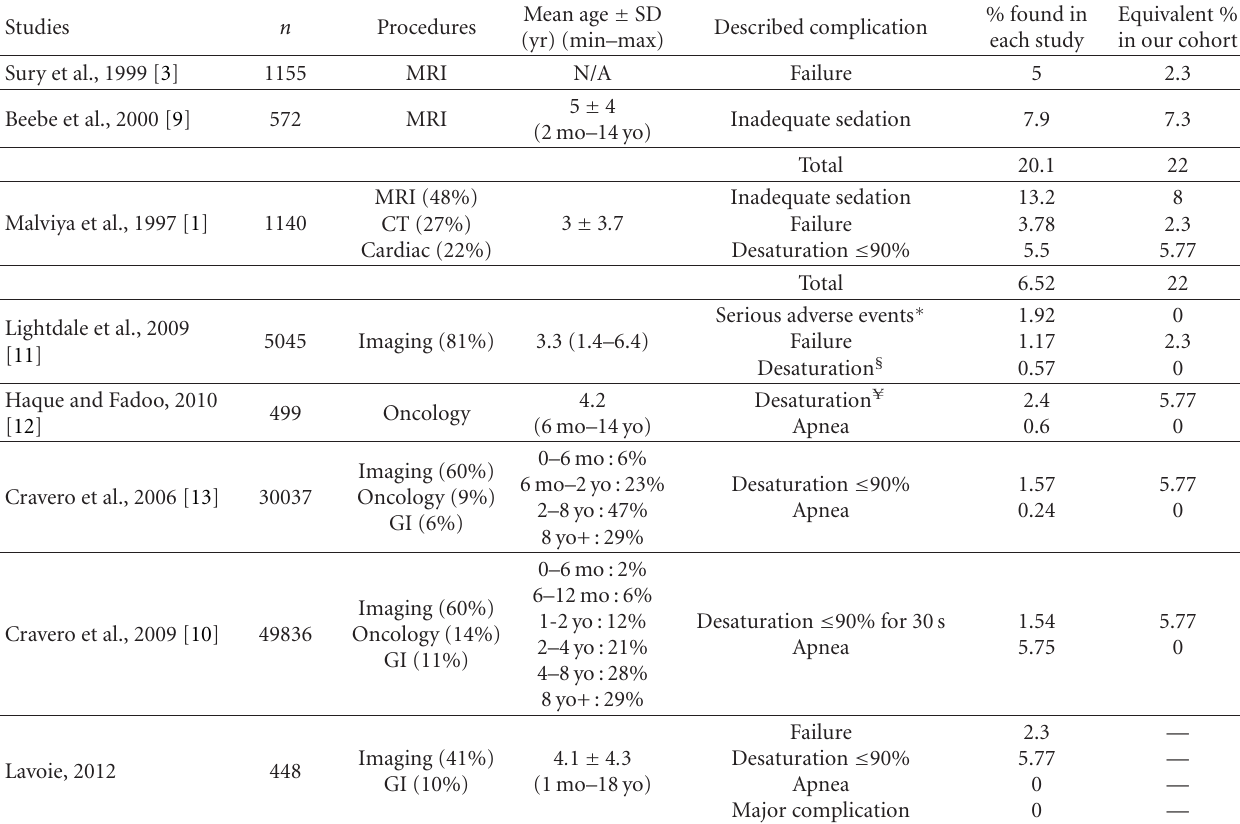
∗ Serious adverse e ff ects define as allergic reaction, aspiration, cardiovascular complications, need for resuscitation, unplanned admission, use of reversal agents, abnormal SpO2, prolonged sedation, and paradoxical reaction. § Desaturationdefines as a sustained dropin oxygen saturation 5% from baseline for more than 1 minuteand unresponsive to blow-by oxygen at 6L/min, and/ or head repositioning, suctioning, or stimulation. (cid:2) Transient desaturation which was improved by head repositioning and increasing oxygen